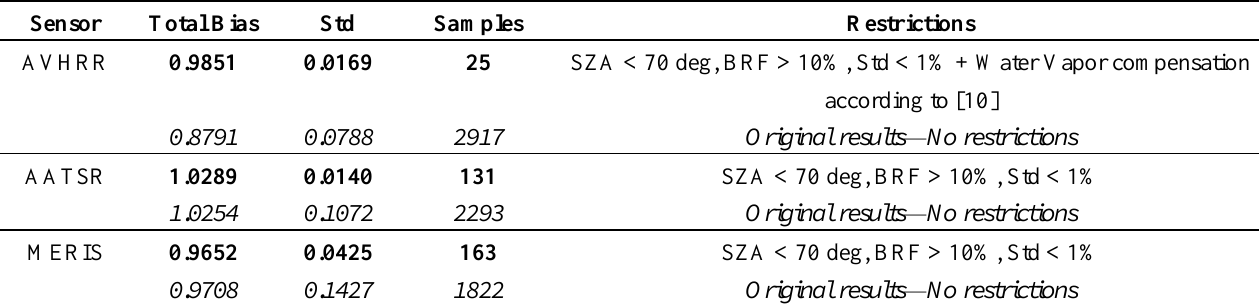
Table 3. Summary of results for all SNO match-up targets for the AVHRR-heritage channel at 0.9 µm based on inter-comparisons with MODIS on AQUA. The total bias is expressed as the relative bias ( i.e. , reflectance factor quota or radiance